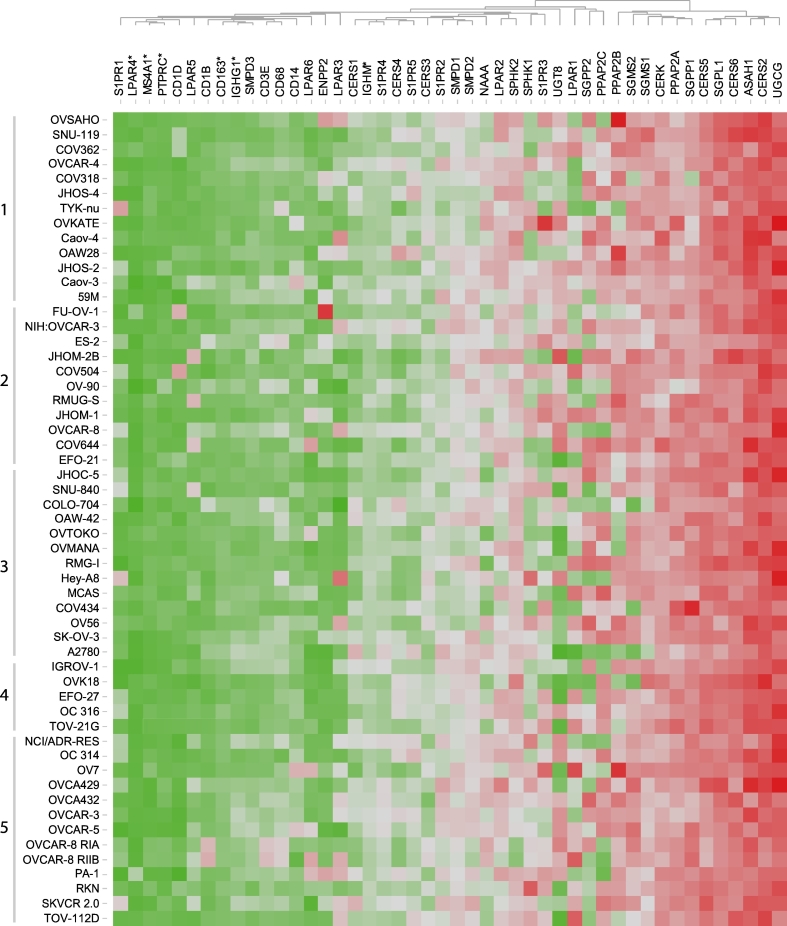
Heat map representing the expression profiles of genes composing the sphingolipid/lysophosphatidate/immune-associated signature in a wide range of ovarian cancer cell lines. Expression values (log2 transformed) for individual genes across 55 ovarian cancer cell lines were extracted using GENEVESTIGATOR. Expression values were subjected to unsupervised hierarchical clustering using Euclidean distance measurement (average linkage clustering). Color code: red, high expression (max 17.25); green, low expression (min 7.13). Genes exhibiting expression at microarray detection limit are indicated by asterisks. Cell lines were grouped into five sub-categories according to Domcke S. et al. [64]: 1, likely high-grade serous; 2, possibly high-grade serous; 3, unlikely high-grade serous; 4, hyper-mutated; 5, unclassified. (For interpretation of the references to color in this figure legend, the reader is referred to the web version of this article.)